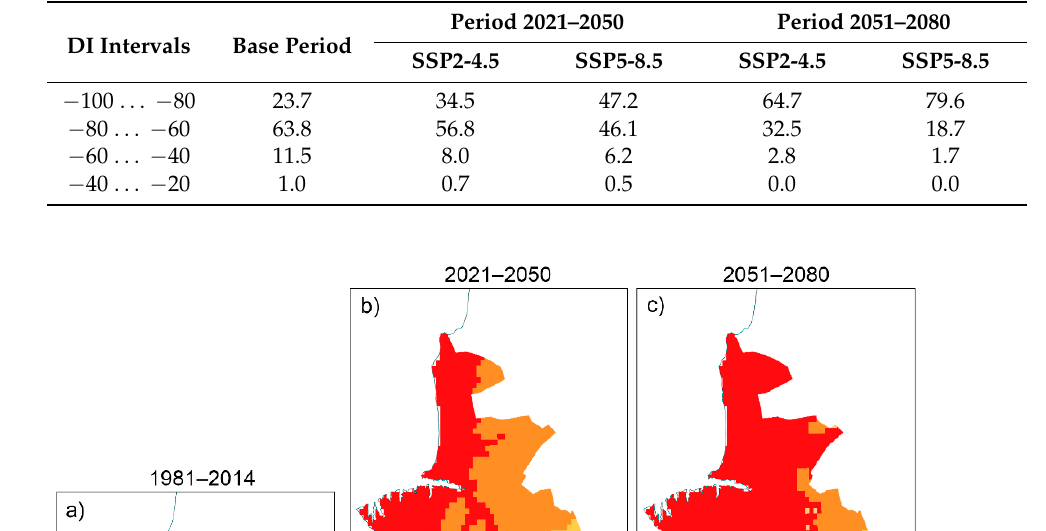
Table 3. Distribution of areas (in %) with various DI intervals.